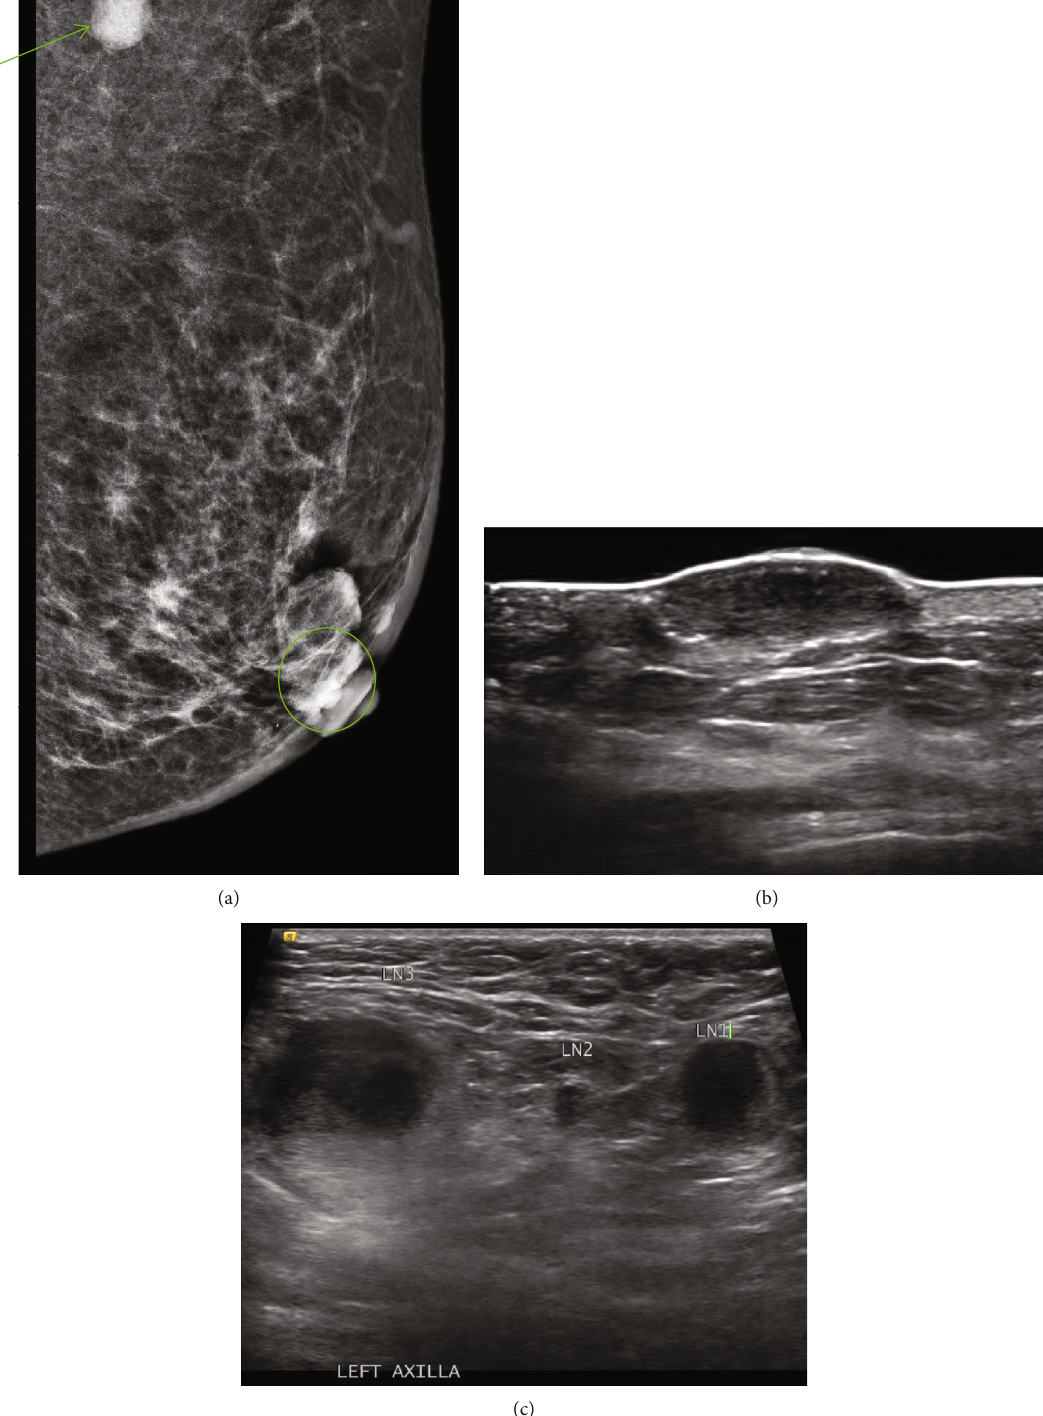
Figure 2: (a) Mediolateral oblique mammogram of the left breast showing a circumscribed periareolar opacity (circle) and dense axillary lymph node (arrow). (b) Super fi cial hypoechoic nodule on left breast sonography. (c) Lymphadenopathy on left axilla